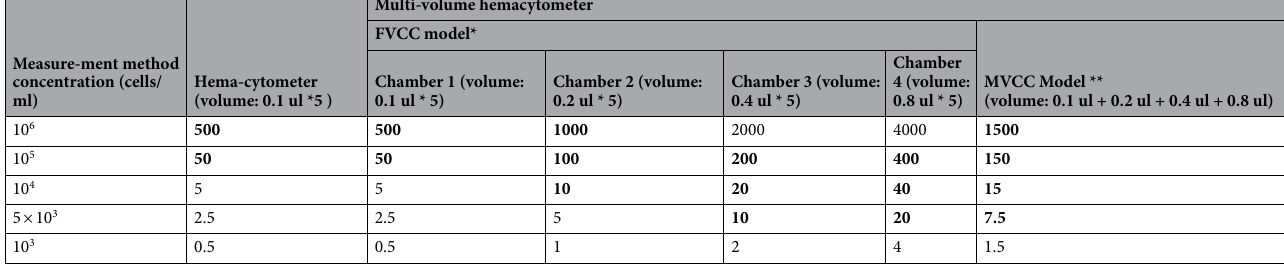
Table 2. Total cell counts from cell concentration measurements. *FVCC Model: Fixed-Volume Cell Counting Model. **MVCC Model: Multi-Volume Cell Counting Model. Bold values Cell concentration measurement